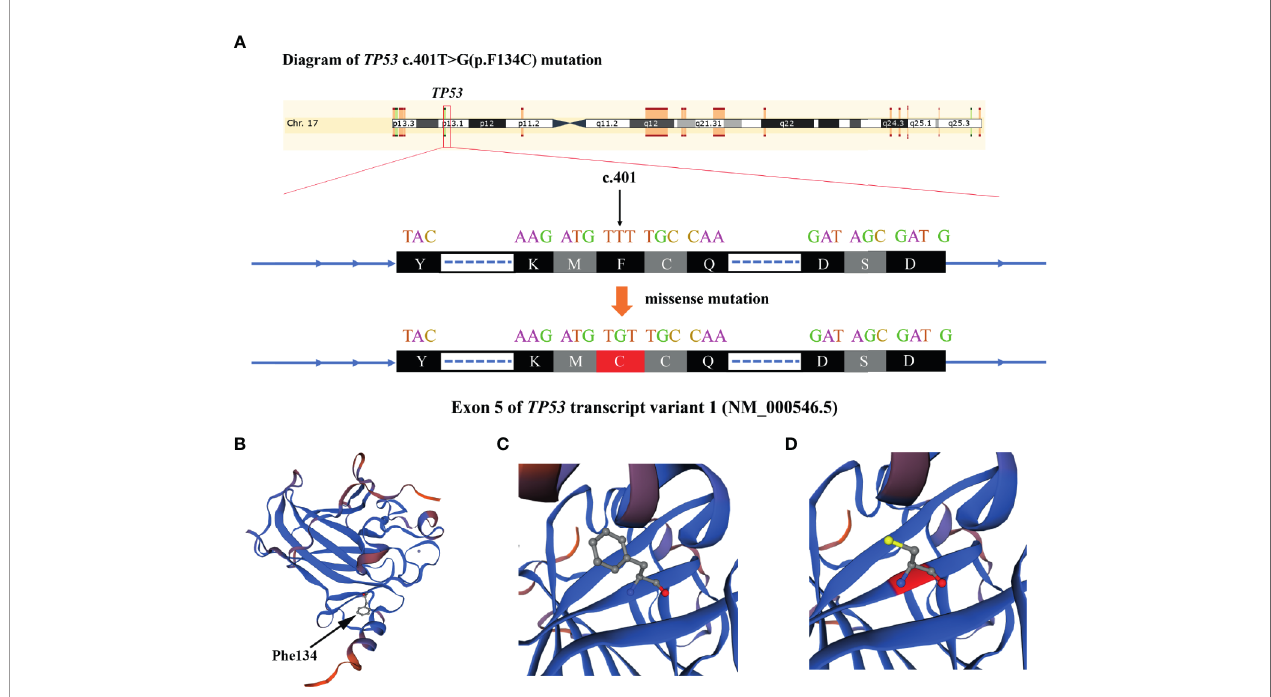
FIGURE 3 | Diagram of TP53 c.401T>G (p.F134C) alteration in Case 2. (A) The base of c.401 mutated from T to G and amino acid changed from phenylalanine to cysteine. (B) The 3-dimentional model structure of TP53 wild-type analyzed by SWISSMODEL. (C) The Phe134 of TP53. (D) The Cys134 of mutated